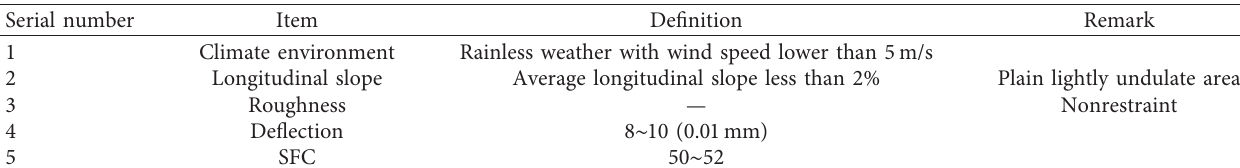
Table 2: Definition of the baseline